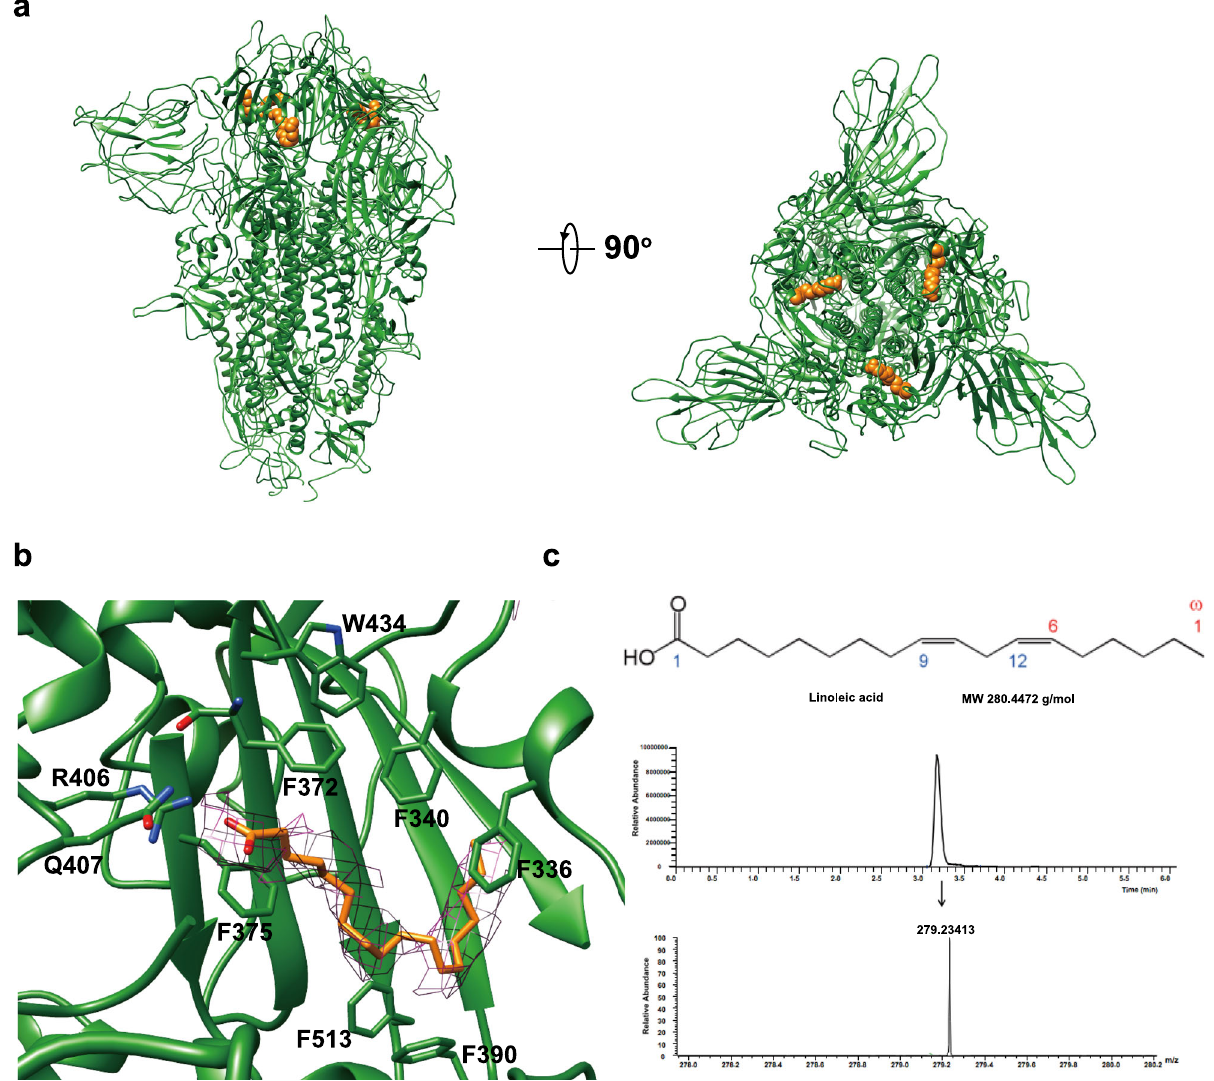
Fig. 4 Binding of linoleic acid (LA) with the PCoV_GX spike. a LA-bound PCoV_GX spike shown in side view and top view. The LA is shown as orange spheres. b LA in the pocket of PCoV_GX spike RBD. LA is shown as orange sticks with EM density and PCoV_GX spike is colored green. LA-interacting amino acid residues are shown as sticks. c LC-MS analysis of extracted lipids from the puri fi ed PCoV_GX spike from two independent experiments. The chemical structure and molecular weight of LA are shown in the top panel, C18 column elution pro fi le in the middle panel, and the molecular weight of corresponding peak in the bottom